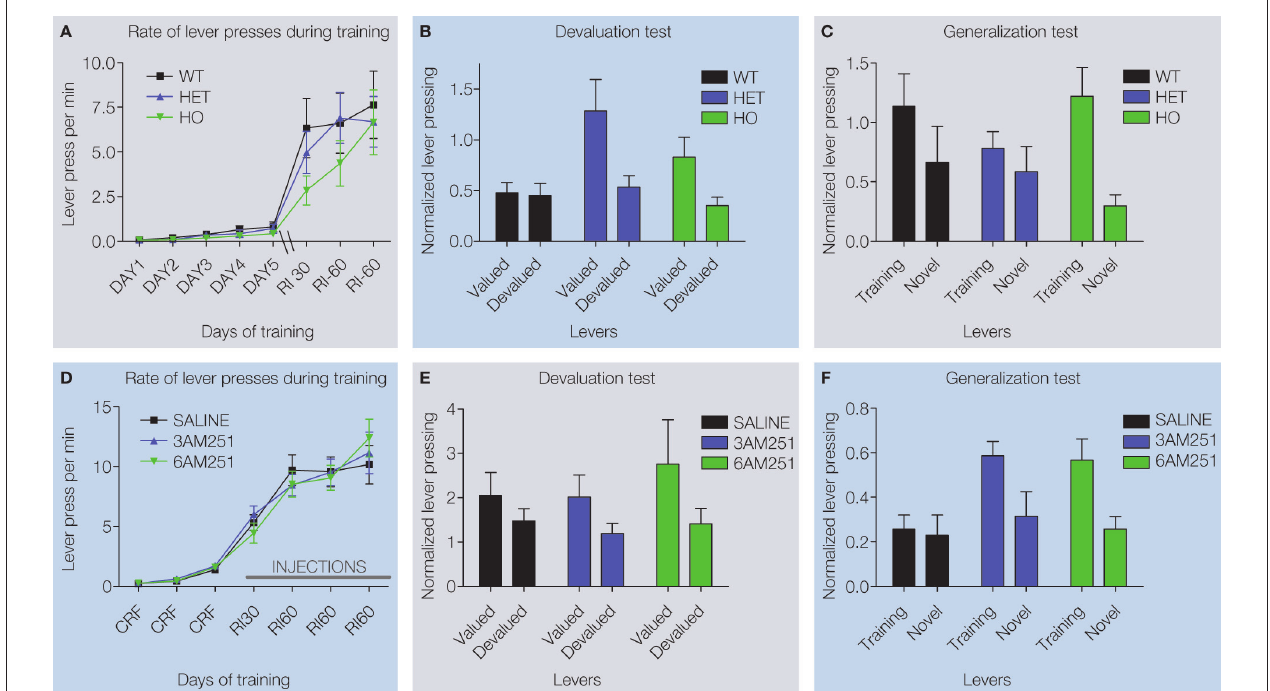
Figure 4 | Decreased predisposition for habit formation in CB1 mutant mice and in C57Bl6/J mice injected with CB1 antagonists during random interval training. (A) Acquisition of the lever pressing task in WT, CB1 + / − and CB1 − / − mice trained in a random interval schedule. The rate of lever pressing (per minute) for each daily session is depicted. (B) Normalized lever pressing during the valued versus the devalued condition for WT, CB1 + / − and CB1 − / − mice. (C) Lever pressing (normalized) on the training lever versus a novel lever in WT, CB1 + / − and CB − / − mice. (D) Acquisition of the lever pressing task for animals